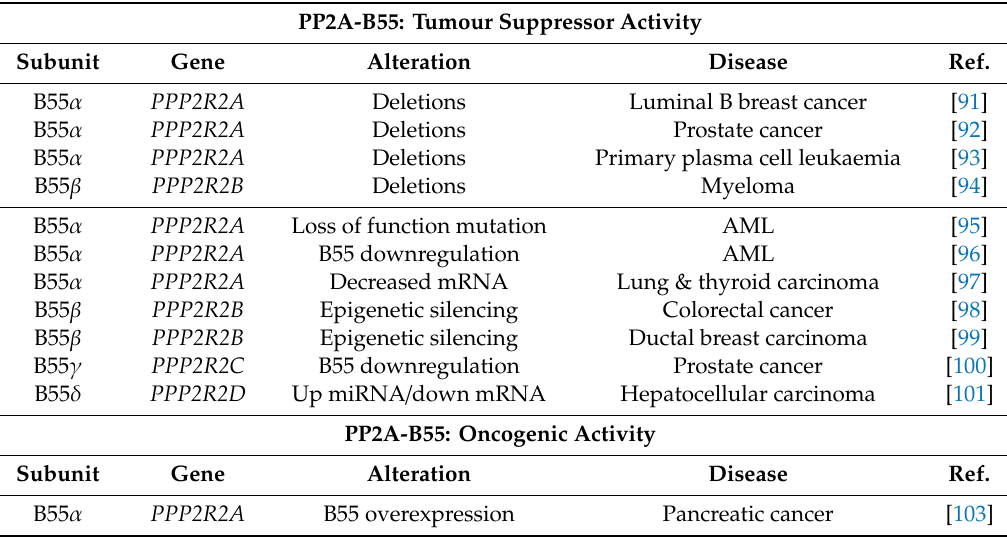
Table 1. Alterations reported for the distinct B55 isoforms in di ff erent types of cancers.